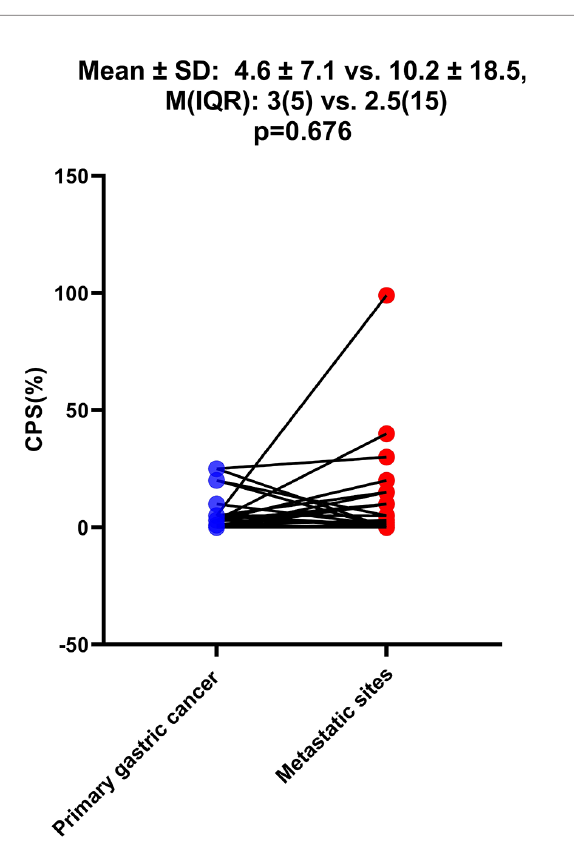
FIGURE 3 | The difference of CPS between gastric mucosa biopsy and postoperative pathology. The Student ’ s paired t-test was used to compare them.